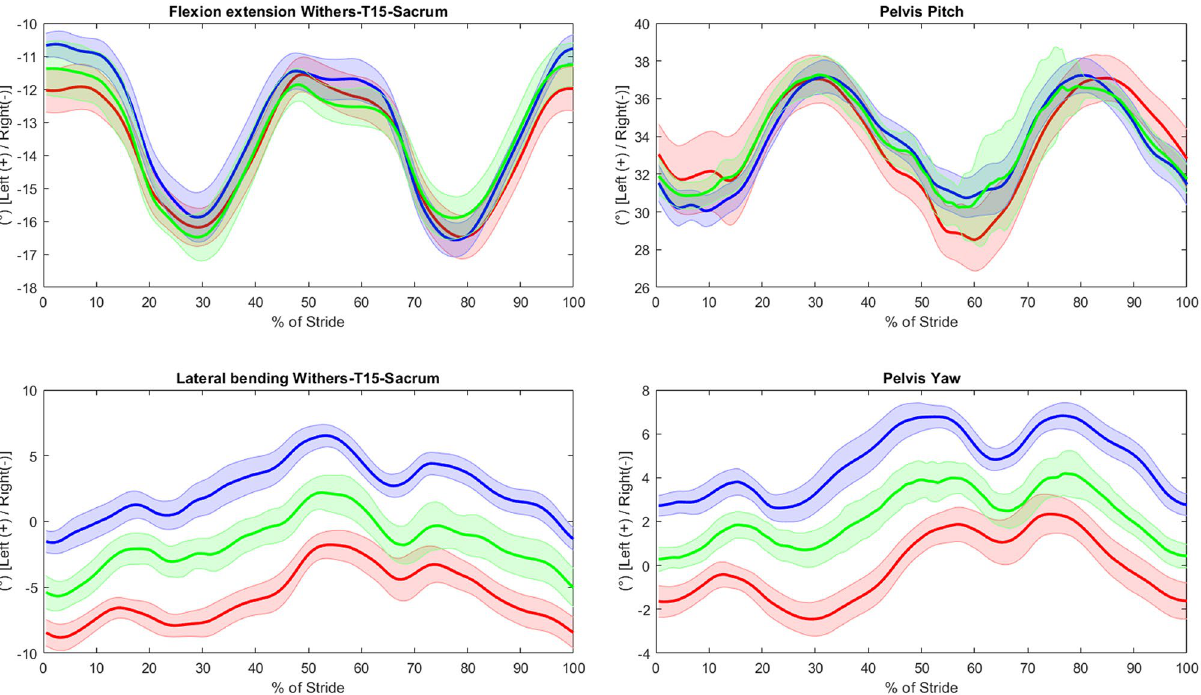
Figure 3. Stride curves (normalized to 0–100% of the stride) for whole back flexion–extension and lateral bending, and pelvis pitch and yaw, for one horse (horse 12). Lines indicate the mean and shaded area the standard deviation, for left circle (red), right circle (blue) and straight line pitch least square mean was 36.9° (indicating an upward slope from the midpoint between the two tubera coxae to the tuber sacrale). Stride mean pelvis yaw showed positive rotation (‘tail towards the right’) on the straight line (2.24°). Ranges of motion for pelvis roll, pitch and yaw were 9.49°, 7.77° and 4.64° (Table 2). The body tracking angle indicated slight tracking of the hindquarters to the right (or forehand to the left) on the straight (0.13°). Combining all results related to horse straightness, the average horse of the study group showed left cervical bending, tracking of the hindquarters to the right, and ‘tail to the right’ yaw rotation of the pelvis relative to the long axis of the body on the straight line. Changes in movements on the circle compared to a straight line. Stride mean flexion-extension (Table 1) indicates that the whole back was slightly more extended on the circle compared to the straight line (estimated differences comparing to straight: left 0.06°; right 0.10°). The same was true for the segments except for T15; statistically significant but small differences were found, with the largest differences at the lumbosacral junction (left 0.82° right 0.64°). For stride mean lateral bending, the whole back (estimated differences left 3.75°; right − 3.61°), as well as all segments, showed left bending on the left circle and right bending on the right circle. The contribution from each of the segments to the whole back lateral bending was approximately equal over the more cranial segments, T12-L3 (estimated differences left 1.1° to 1.4°; right − 1.5° to − 1.0°, compared to straight). For the most caudal segments (L5 and sacral segments), differences were smaller (left 0.22° to 0.34°; right − 0.24° to − 0.22°, compared to straight). Cervical lateral bending to the inside of the circle was symmetric compared to the straight line for left and right circles (differences; left 5.23°; right − 4.80°), but since horses showed left lateral bending on the straight, least square means suggest relatively more bending to the inside on the left circle (least square means − 6.73° vs. 3.30°). Body tracking showed about the same estimated ‘forehand in—hindquarters out’ deviation with hindquarters towards the left on the left circle and to the right on the right circle (differences left − 2.30°; right 2.62°, compared to straight). Differences between circle and straight in ROM were small. For flexion-extension there was no consistent direction of change (Table 2), but estimate signs are generally consistent for the same angle/segment between left and right circles. For lateral bending significant differences indicated increased ROM on the circle. For the whole back the estimated differences were − 0.87° and − 0.62° compared to the straight (negative sign indicates higher values on the circles). Stride mean pelvis roll showed approximately the same estimated differences, with roll to the left on the left circle, and to the right on the right circle (12.4° and 12.7°), compared to almost zero degrees on the straight line (Table 1). For pelvis pitch, differences to straight were − 0.67° and − 0.95°, indicating slightly more extension. Stride mean pelvis yaw was (tail) to the inside compared to straight, to the right on the right circle (difference − 2.22°) and to the left on the left circle (difference 2.46°). Pelvis roll ROM decreased slightly on the circle, by 0.14°–0.15°, whereas pelvis pitch and yaw ROM increased between − 0.31° and − 0.69° (Table 2).